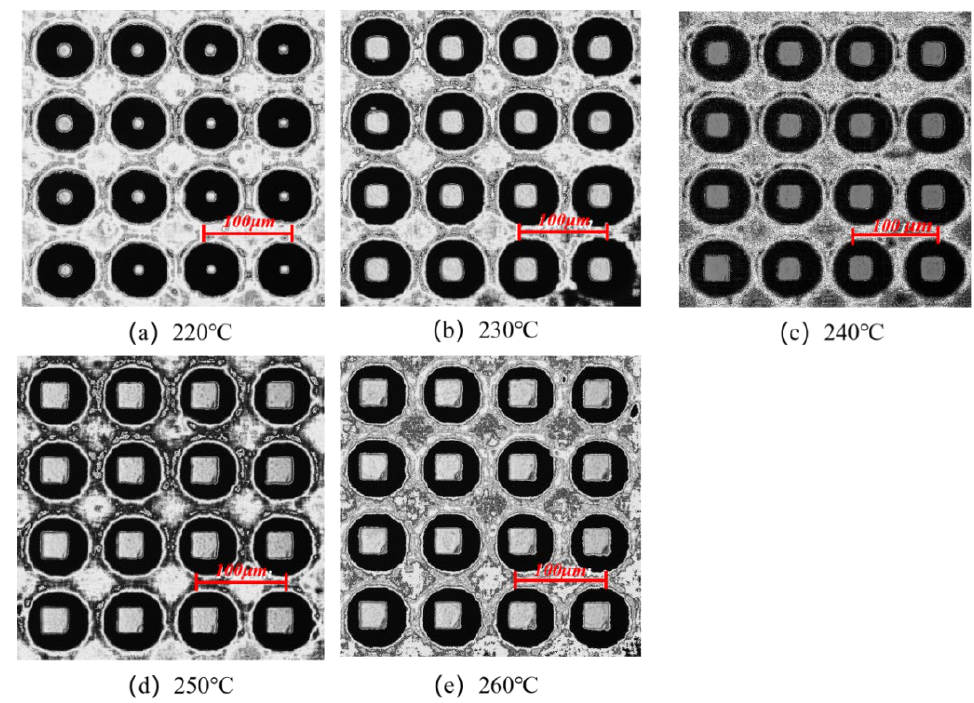
Figure 21. Microstructure replication morphologies at different melt temperatures.